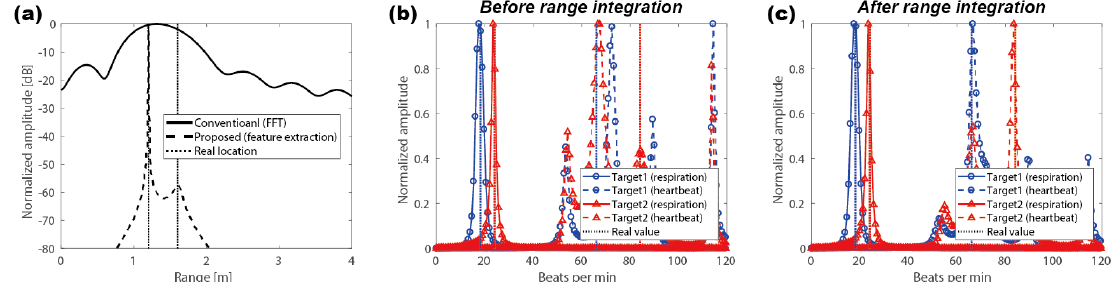
Figure 6. Simulation results for two subjects at distances of 120 and 160 cm: ( a ) range estimation; ( b ) vital sign detection without the range integration; and ( c ) vital sign detection with the range integration.